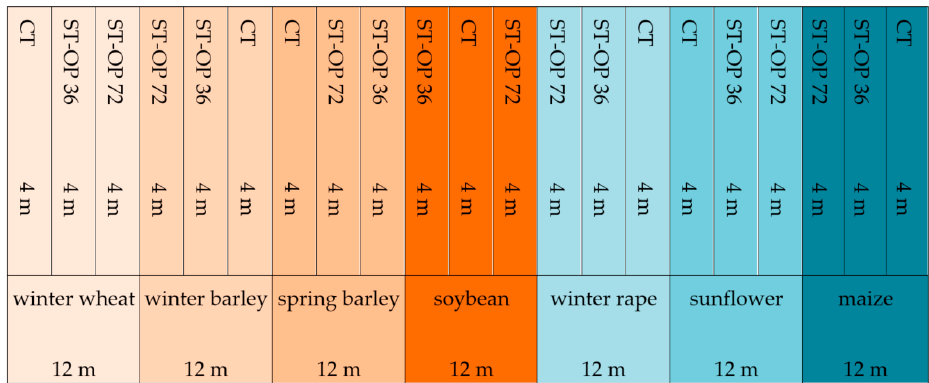
Figure 1. Scheme of arrangement of previous crops and succeeding one to estimate the impact of the tillage method on plant residues, one of three replications. CT, conventional; ST-OP 36, strip-till one-pass, 36 cm strip spacing; ST-OP 72, strip-till one-pass, 72 cm strip spacing. The ST-OP cultivation was performed using a Mzuri Pro-Til hybrid machine. The machine cooperated with the tractor Claas Axion 850, speed about 7–8 km/h. Wheat was sown in two rows in 12 cm strips of loosened soil with 36 cm row spacing. The machine’s loosening tines and sowing coulters loosen the soil and mix it with the plant residues to form small contour ridges in the unloosened 24 cm wide inter-row (Figure 2A). Maize was sown in a single row in the middle of the